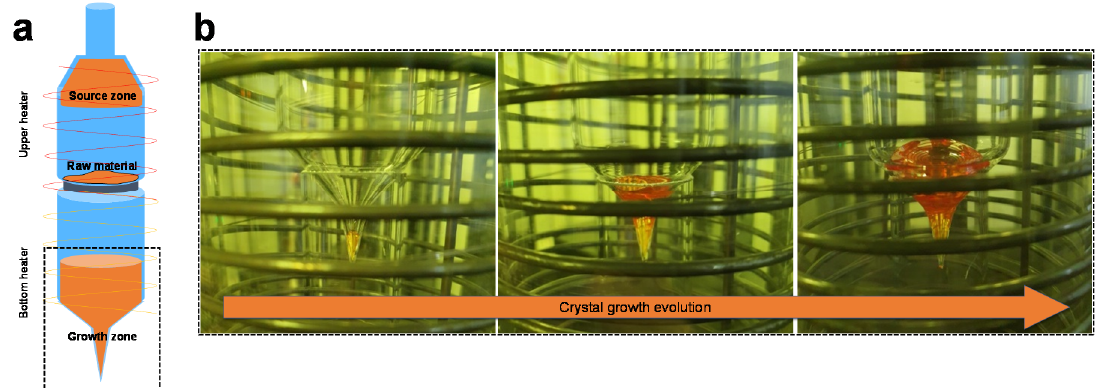
Figure 2. ( a ) Schematic of the physical vapor transport system designed for Hg 2 Br 2 crystal growth. ( b ) Crystal growth evolution process in quartz ampoule.